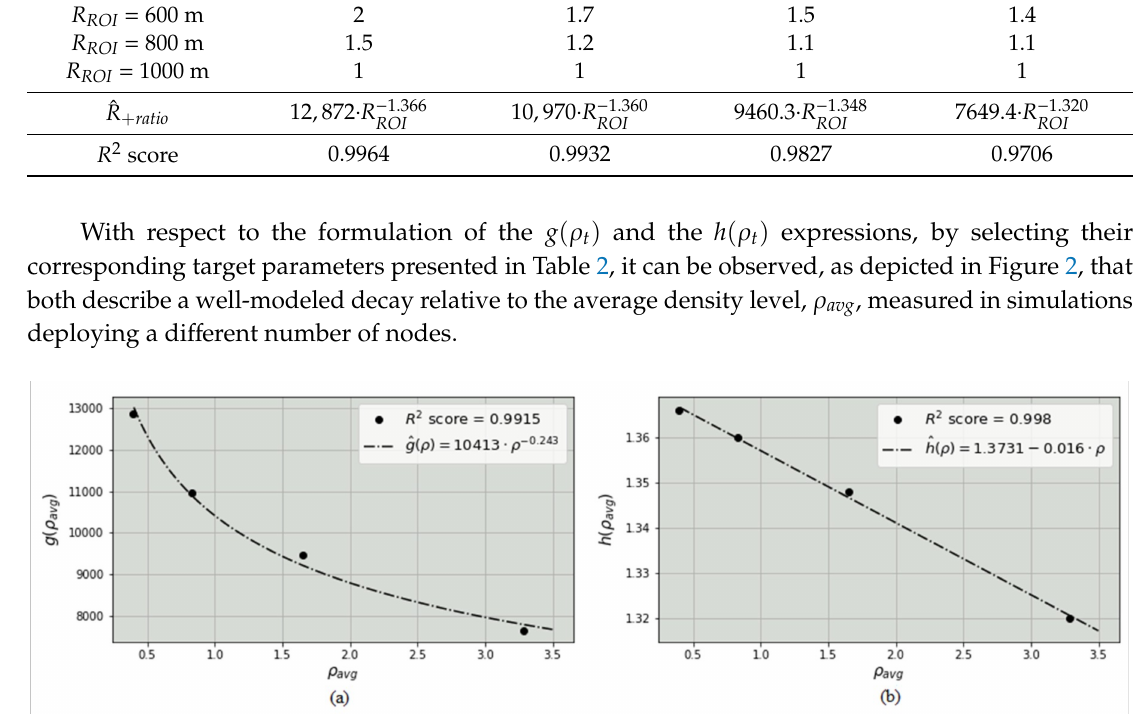
Figure 2. Regression-based model for the: ( a ) g ( ρ t ); and ( b ) h ( ρ t )